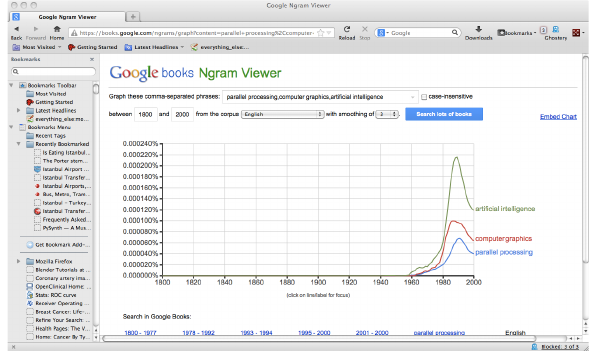
Figure 5. Google N-Gram Viewer